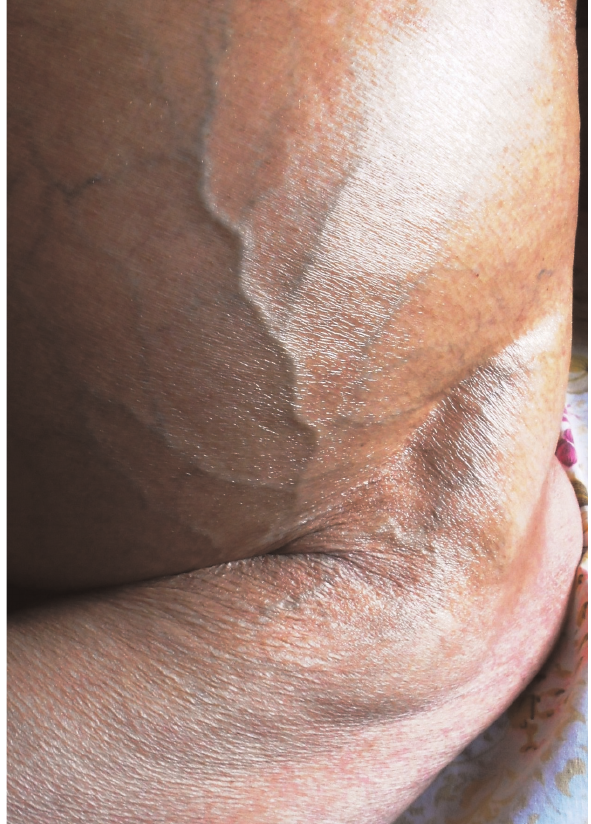
Figure 4. Dilated super fi cial veins in lower abdomen with upward fl ow in a patient with chronic HVCS who developed ascites from severe acute exacerbation. Patient had neutro- phil leukocytosis and very high level of CRP and ascitic fl uid had high protein content, high SAAG, and very high absolute neutrophil count. Patient recovered from treatment with diuretics and antibiotic for 8 weeks. (Copyright: Santosh Man